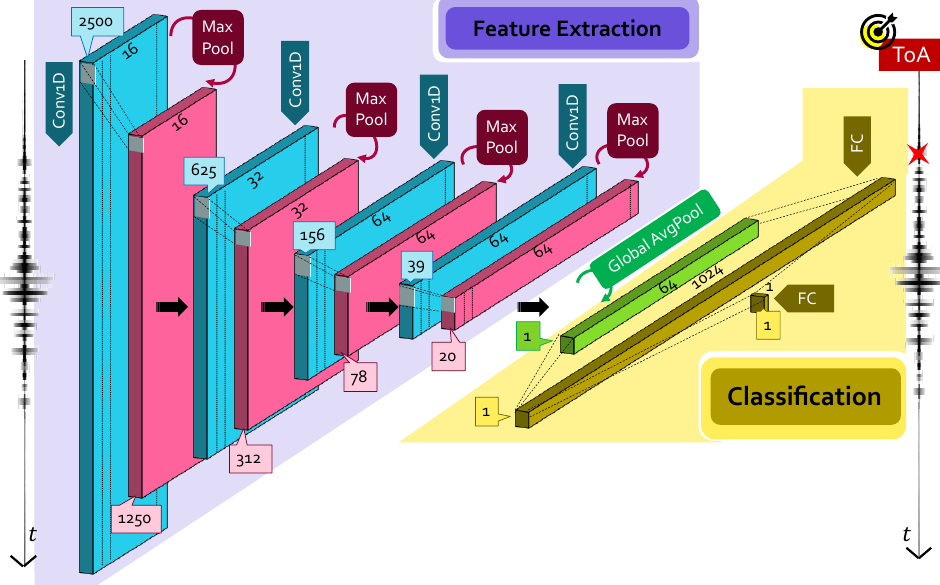
Figure 3. Proposed small CNN for ToA estimation. The quantities reported in the blue and pink boxes indicate the dimensions of the output features of the corresponding